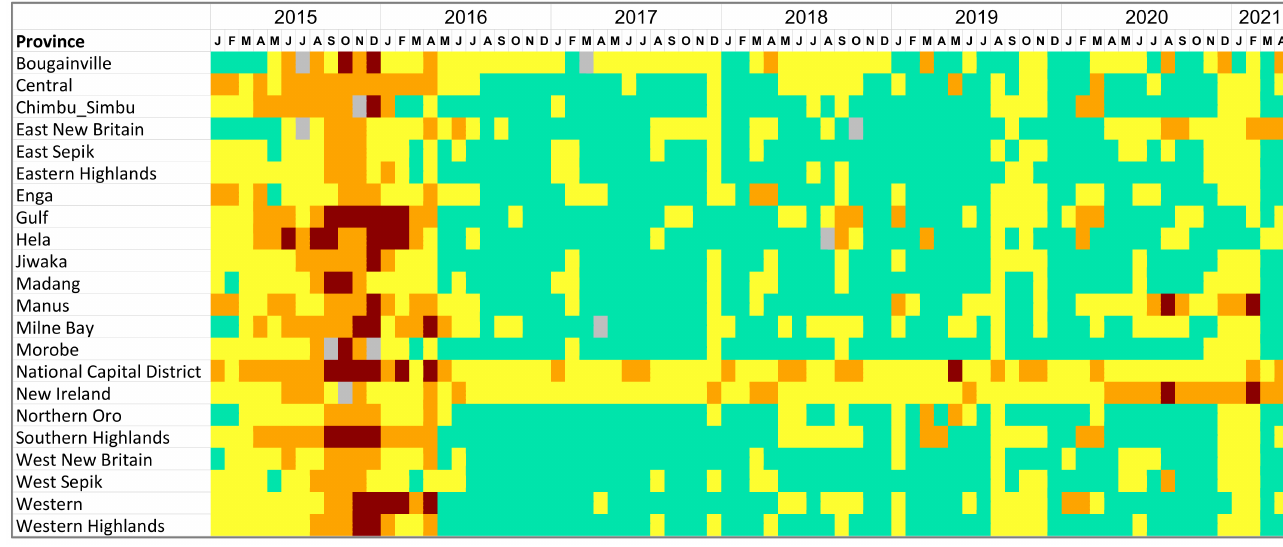
Figure 17. Same as Figure 12 but for months with equally high modal statuses indicated in